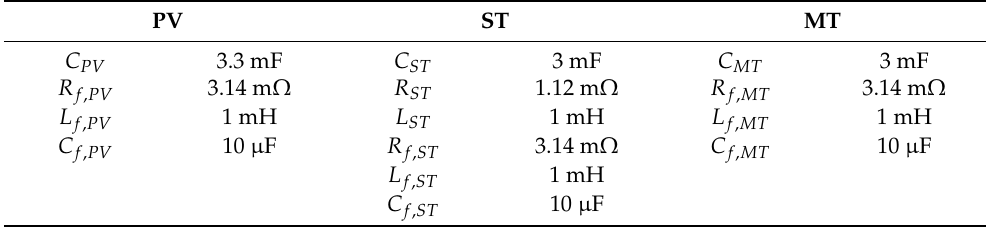
Figure 5. One-line diagram of test case MG. Table 2. Source parameters.